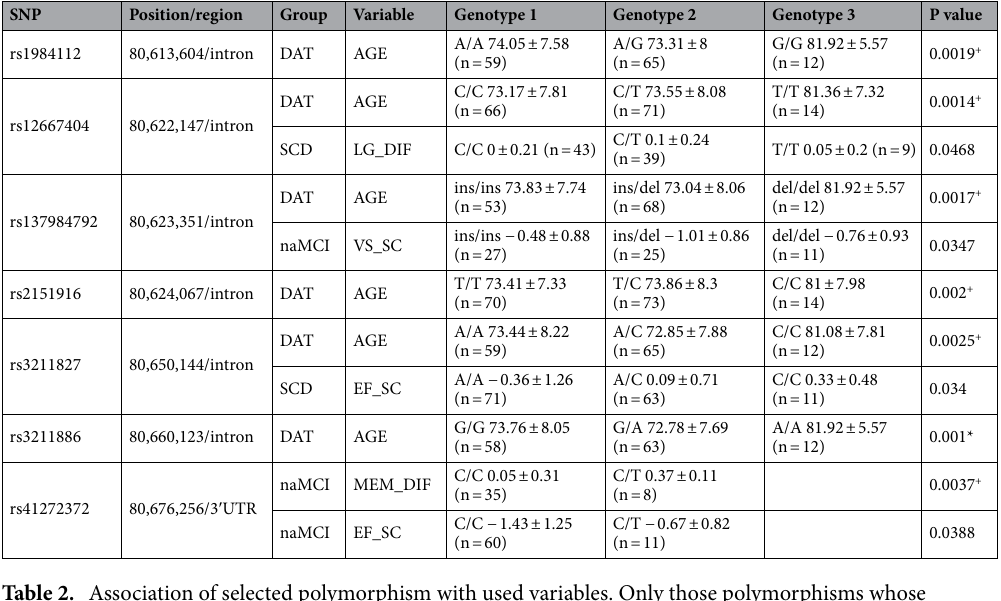
Table 2. Association of selected polymorphism with used variables. Only those polymorphisms whose association with any of the variables was statistically significant at a significance level of 0.1 after correction for multiple comparisons are reported. For these, the mean values ± standard deviations of the variables for which P values were lower than 0.05 are given. SCD subjective cognitive decline, naMCI non-amnestic mild cognitive impairment, DAT dementia of the Alzheimer’s type, AGE the age at the first examination in years, EF_SC the domain of the executive function residual z-score at the first examination, LG_SC the language domain residual z-score at the first examination, MEM_SC the memory domain residual z-score at the first examination, VS_SC the visuospatial memory domain residual z-score at the first examination, MEM_DIF average increment of MEM_SC per year during the 2 years since the first examination (intercept of the OLS regression line), LG_DIF average increment of LG_SC per year during the 2 years since the first examination (intercept of the OLS regression line). *P values significant at 0.05 after correction for multiple comparisons, + P values significant at 0.1 after correction for multiple comparisons, n—sample